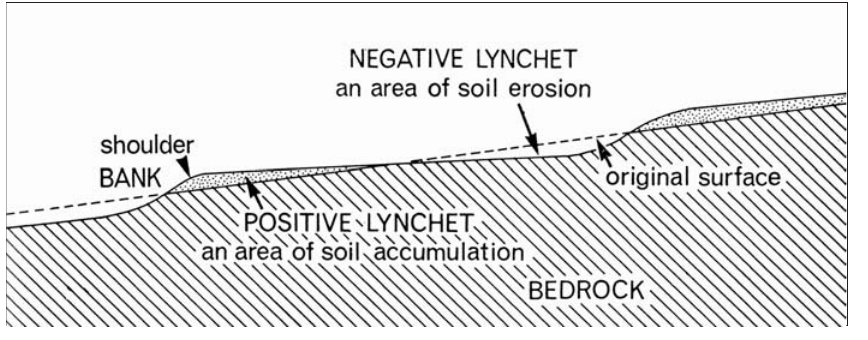
Figure 1 The formation of lynchets. (after J. W. MacNab , “British strip lynchets”, Antiquity 39, fig. 1,